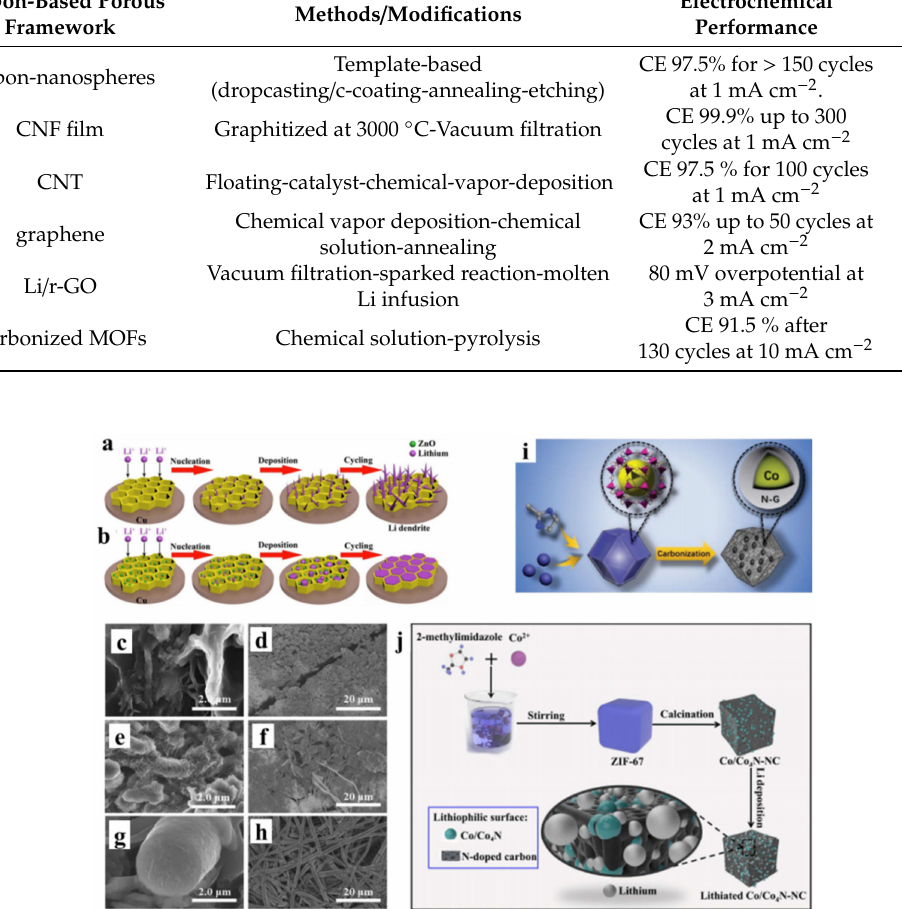
Figure 6. Lithiophilic metal oxides and all in one decorated porous carbon. ( a , b ) Schematic representation of Li nucleation and deposition during the plating mechanism within the hierarchical porous carbon (HPC) sca ff old with and without the lithiophilic ZnO. Reproduced with permission from [10], Elsevier, 2017. ( c – h ) SEM images of Li deposition on Cu, carbon fiber, and carbon fiber with amorphous lithiophilic SiO 2 and TiO 2 . Reproduced with permission from [96], John Wiley and Sons, 2019. ( i ) Schematic demonstration of the preparation process of Co@N-G. Reproduced with permission from [99], John Wiley and Sons, 2019. ( j ) Schematic representation of preparation for lithiophilic Co / Co 4 N-NC. Reproduced with permission from [100], Royal Society of Chemistry,